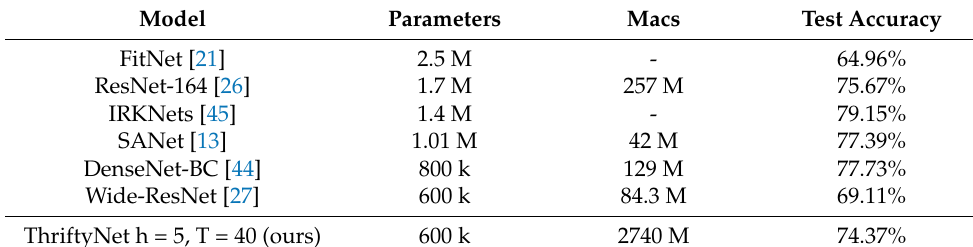
Table 4. Comparative results on CIFAR-100.